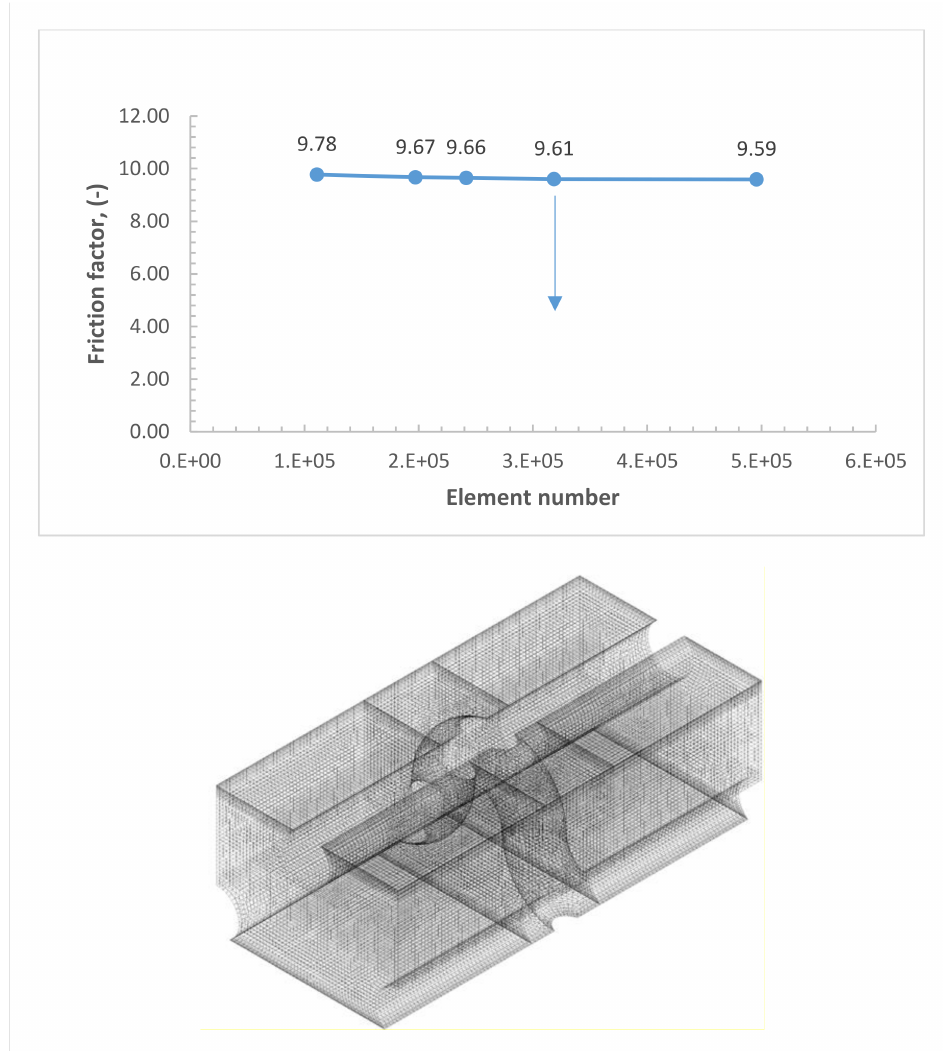
Figure 4. Mesh dependence analysis and the adopted mesh for this